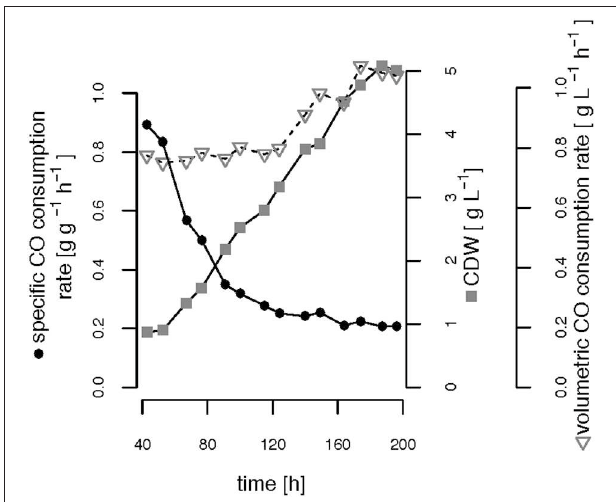
FIGURE 8 | Growth-limiting CO consumption rates. The volumetric and specific CO consumption rates and the cell dry weight (CDW) are shown over time during phases (ii) and (iii) of the C-limited